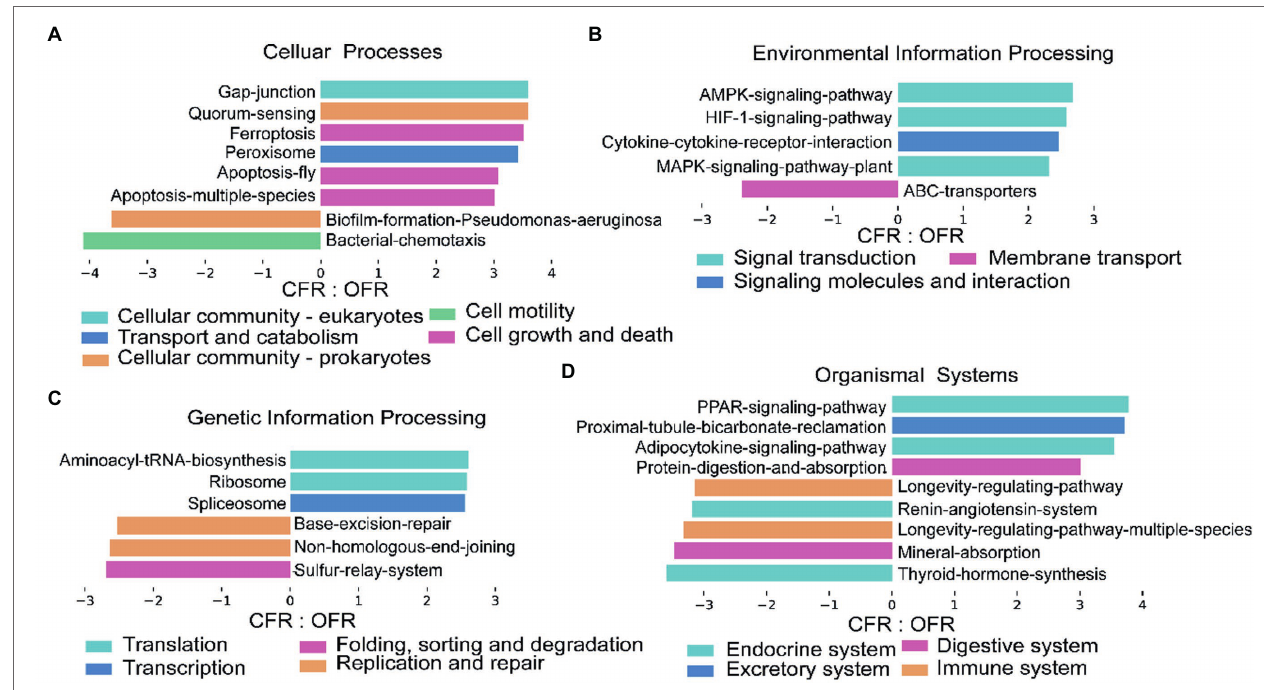
FIGURE 5 | Histograms showing the gene pathways with significant differences between CFR and OFR. (A-D) represent functions corresponding to cellular processes, environmental processes, general processes and organic systems, respectively. There is a description above each figure, and it would be redundant to describe it in the title. Other similar studies also operate in this way (Schmidt et al.,